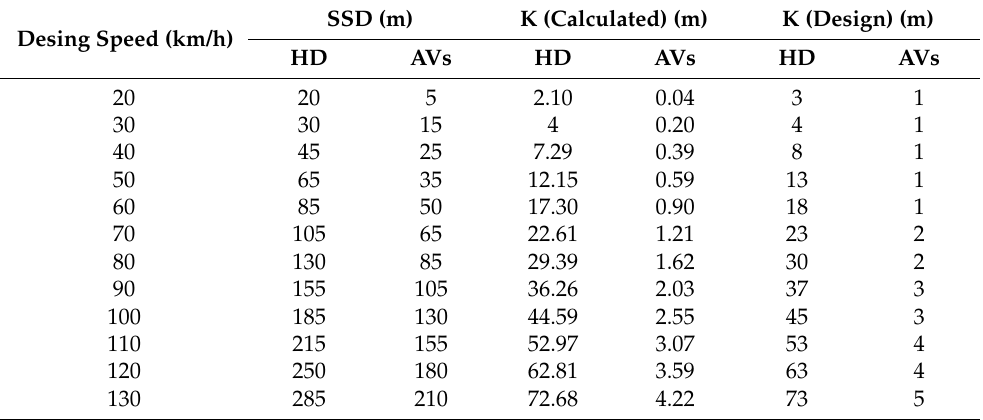
Table 6. Design Controls for Sag Vertical Curves Based on Stopping Sight Distance for human-driven and